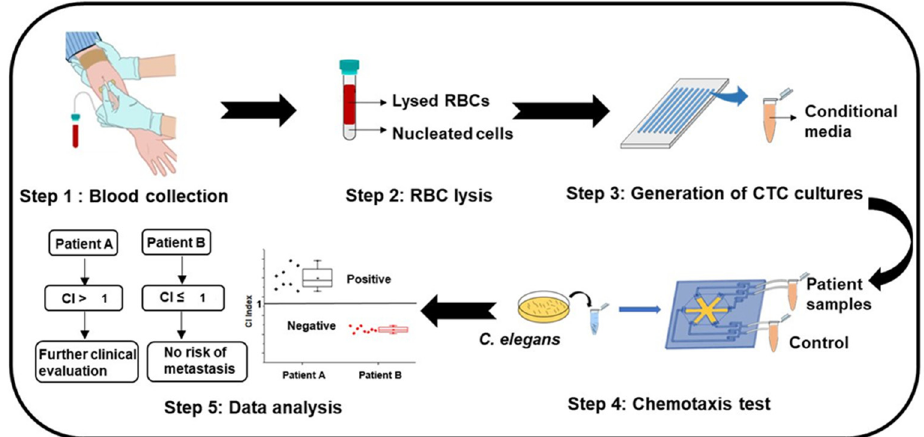
Figure 6. The proposed workflow of the WB biosensor for clinical utility. Step 1: collection of blood from patients. Step 2: preprocessing of samples to remove red blood cells through lysis. Step 3: short-term culture of nucleated cells under suitable conditions to generate CTC clusters [54]. Step 4: collection of samples from patient-derived cultures for rapid screening with the WB biosensor. Step 5: analysis of the chemotactic index (CI). A positive index (CI > 1) reflects the need for further evaluation, while a negative index reflects no metastasis risk. RBC = red blood cells; CTC = circulating tumor cell.